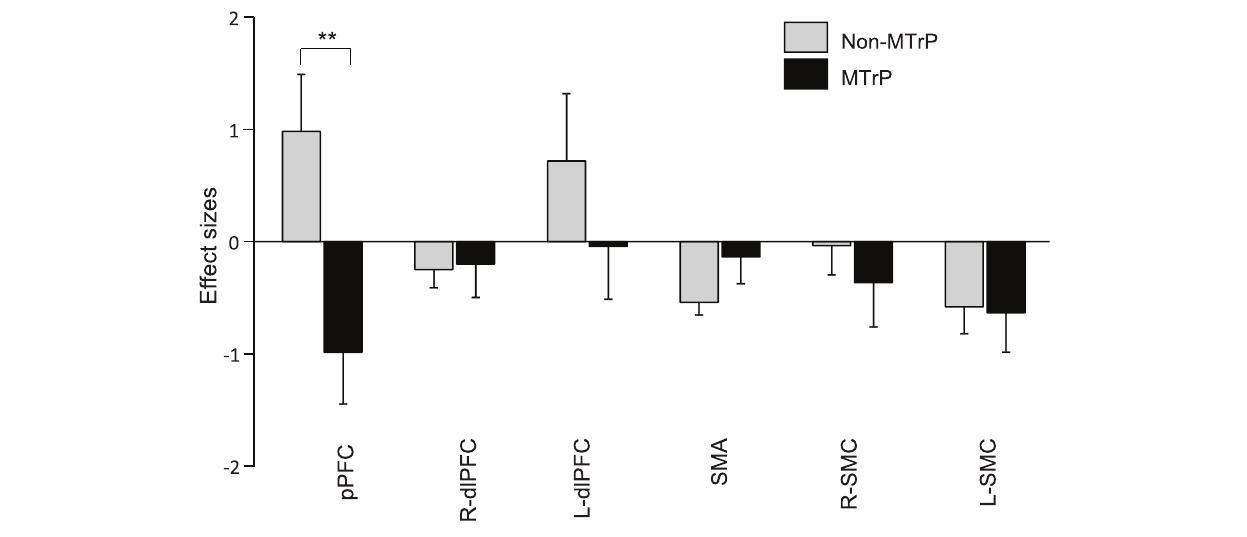
FIGURE 5 | Comparison of hemodynamic responses in each ROI during compression between the MTrP and non-MTrP groups. Effect sizes of hemodynamic responses during compression was significantly decreased in the MTrP group compared with non-MTrP. pPFC, frontal polar area in the PFC; dlPFC, dorsolateral PFC; SMA, supplementary motor area; L-SMC, left primary sensorimotor cortex; R-SMC, right primary sensorimotor